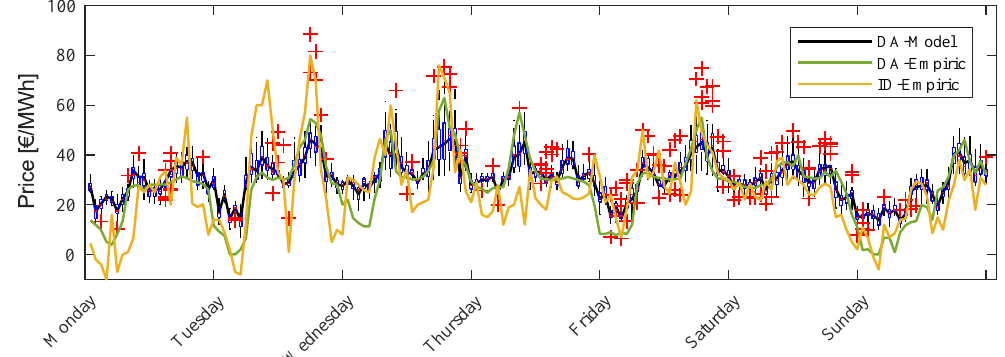
Figure A2. Modeled DA price and ID price distributions (displayed as box-plot: blue boxes and red crosses) as well as the empiric DA price and ID price for the second week of January 2014 according to [17].